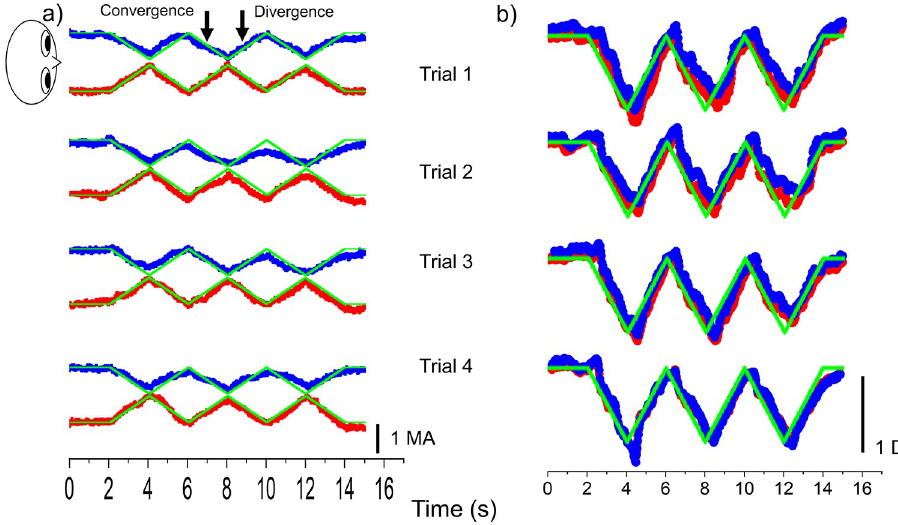
Fig 1. Vergence (a) and accommodative (b) responses of a healthy volunteer stimulus in the visual task. The blue, red, and green squares indicate the left eye, right eye, and stimuli, respectively. The healthy volunteer maintained binocular coordination during the visual task. MA, meter angle; D, diopter.